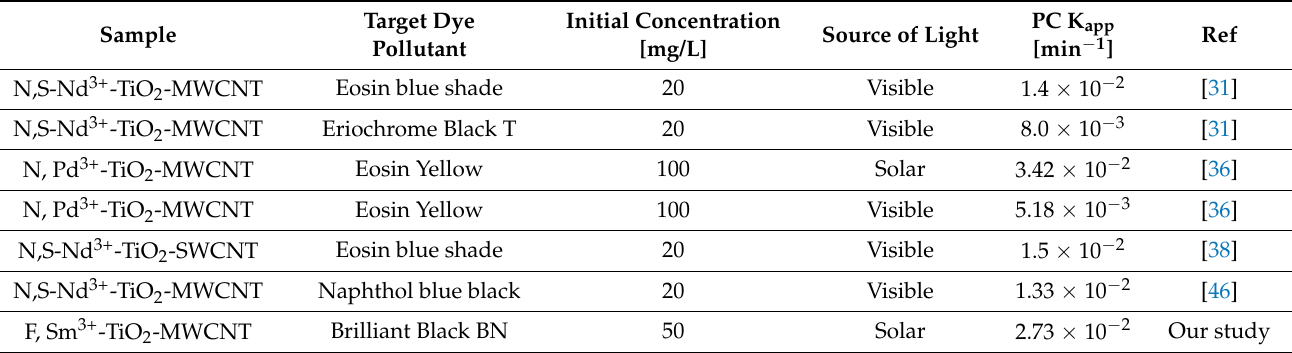
Table 5. Comparing the photocatalytic results in our study with other non-metal, metal multi-doped TiO2-MWCNT heterostuctures for photocatalytic activity